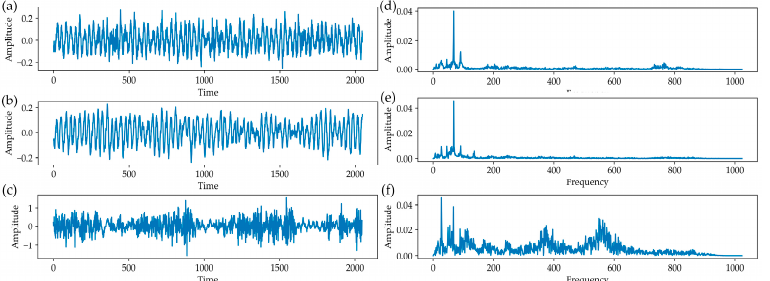
Figure 7. Time-domain signals and their corresponding spectrums under different operating states; ( a – c ) vibration signals of the bearings in the states of normal, spalling and wear, respectively; ( d – f ) corresponding spectrums.